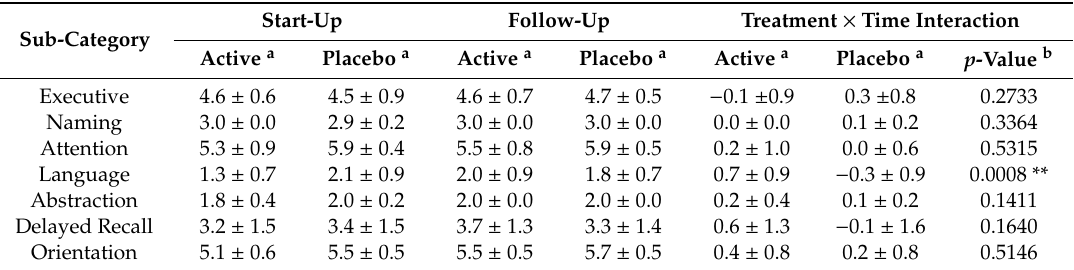
Table 5. Two-way analysis of treatment × time interaction in each cognitive domain scores of MoCA of active and placebo groups for female subjects.